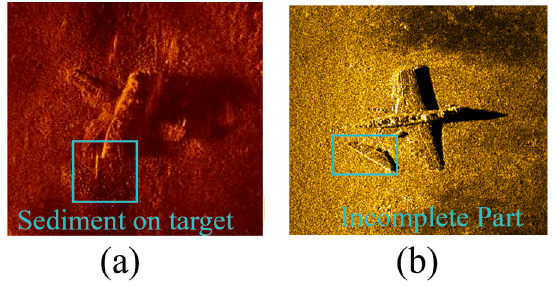
Figure 12. Examples of incomplete target. ( a ) Sediment on target. ( b ) Defective target.